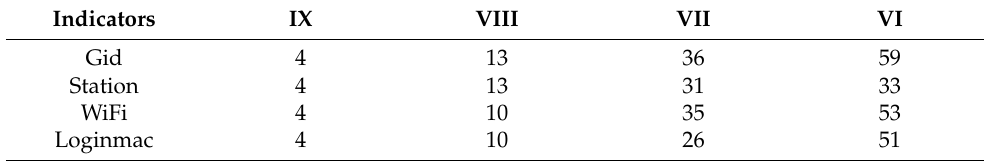
Table 2. Number of GeoHash grids of the four types of signaling in different intensity areas. Indicators IX